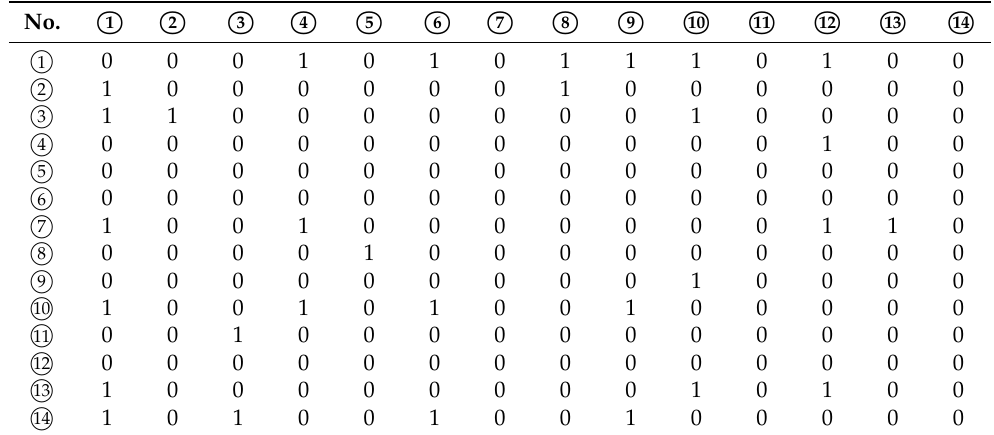
Table 4. The AM result of barriers.